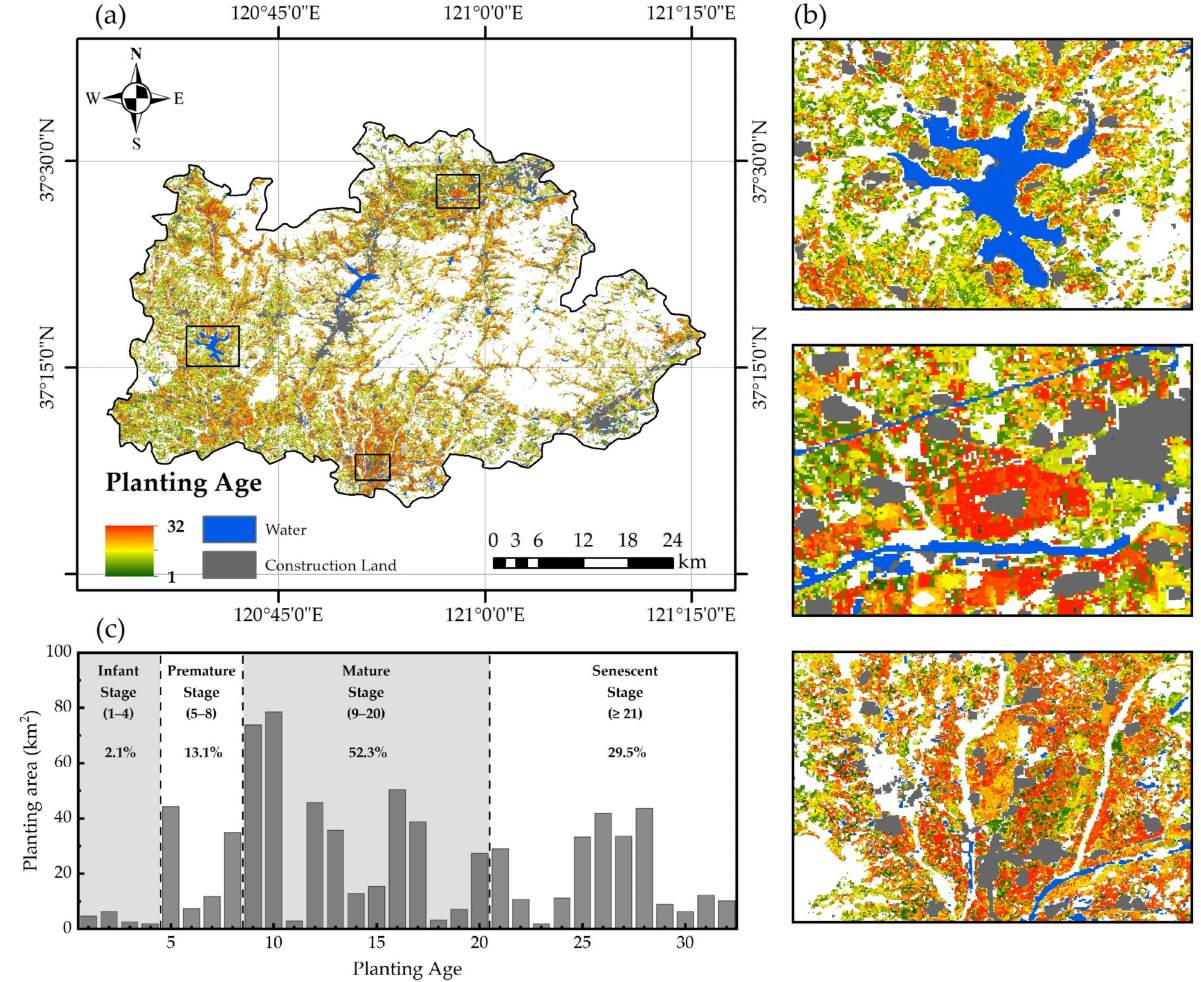
Figure 7. Assessment Results of Orchard Planting Age. ( a ) Planting age estimation results. ( b ) Details of the planting age estimation results. ( c ) Percentage of orchard area of different ages in Qixia